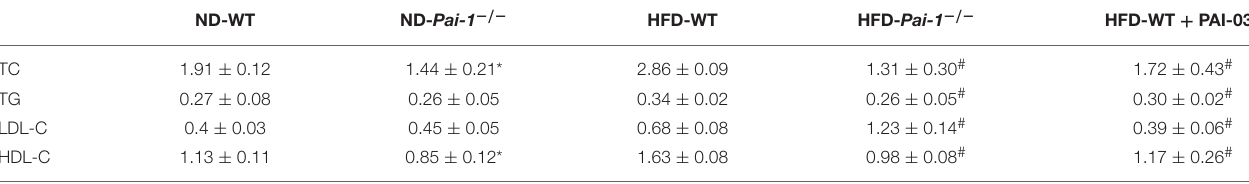
TABLE 1 | Plasma lipid